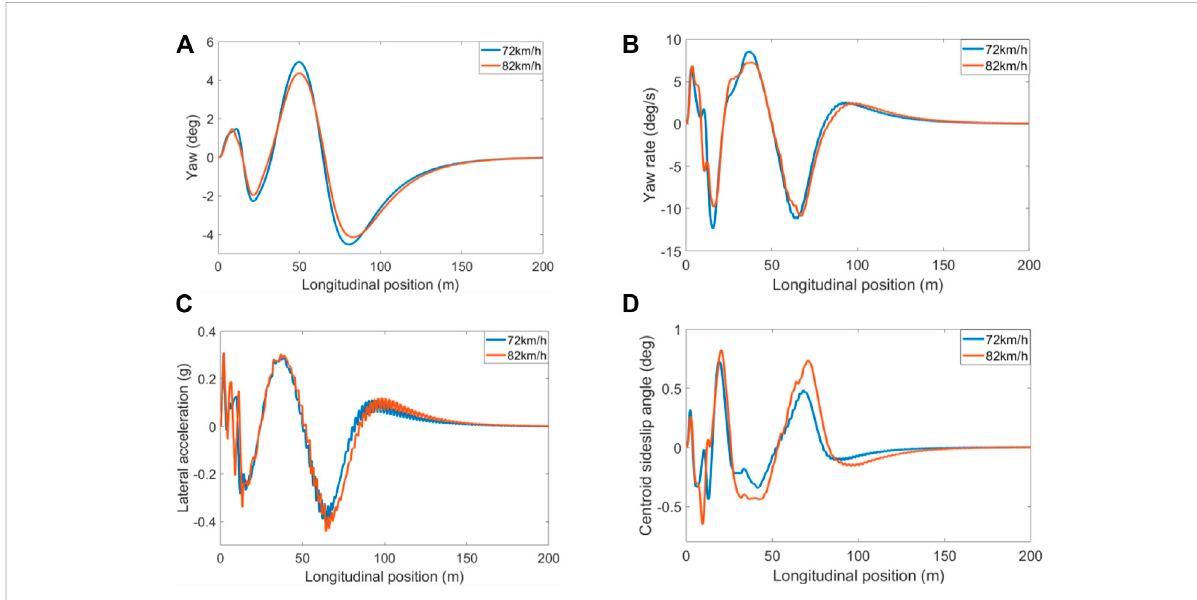
FIGURE 7 Simulation results of vehicle parameters. (A) Yaw; (B) Yaw rate; (C) lateral acceleration; (D) sideslip angle.